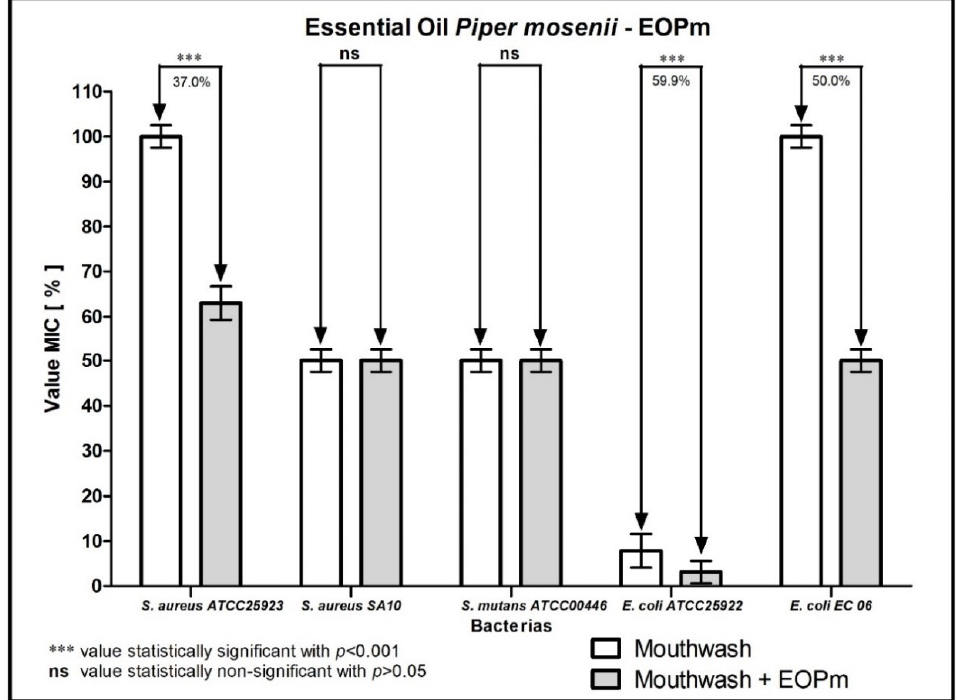
Figure 2. Evaluation of the modulating activity of EOPm combined with mouthwash against bacterial strains.